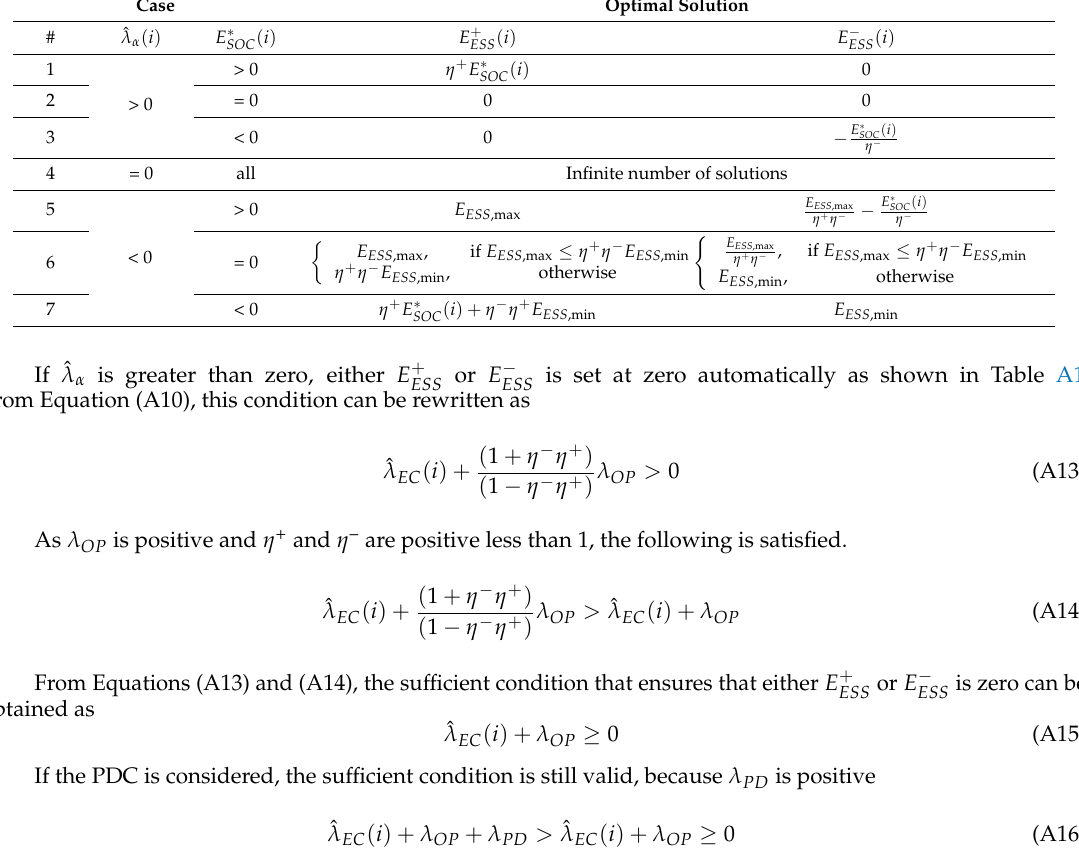
Table A1. Optimal E +